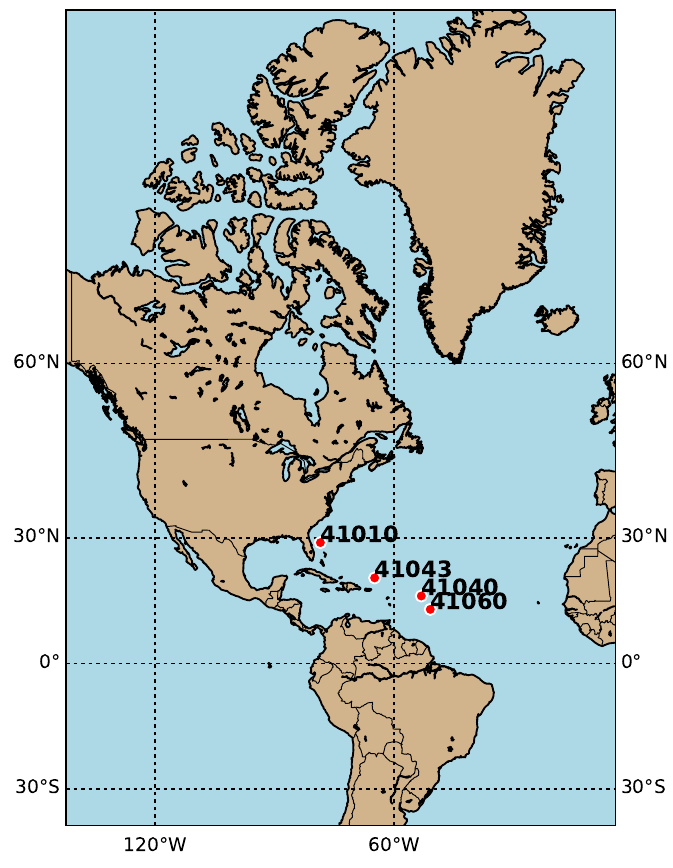
Figure 1. Stations’ location in the